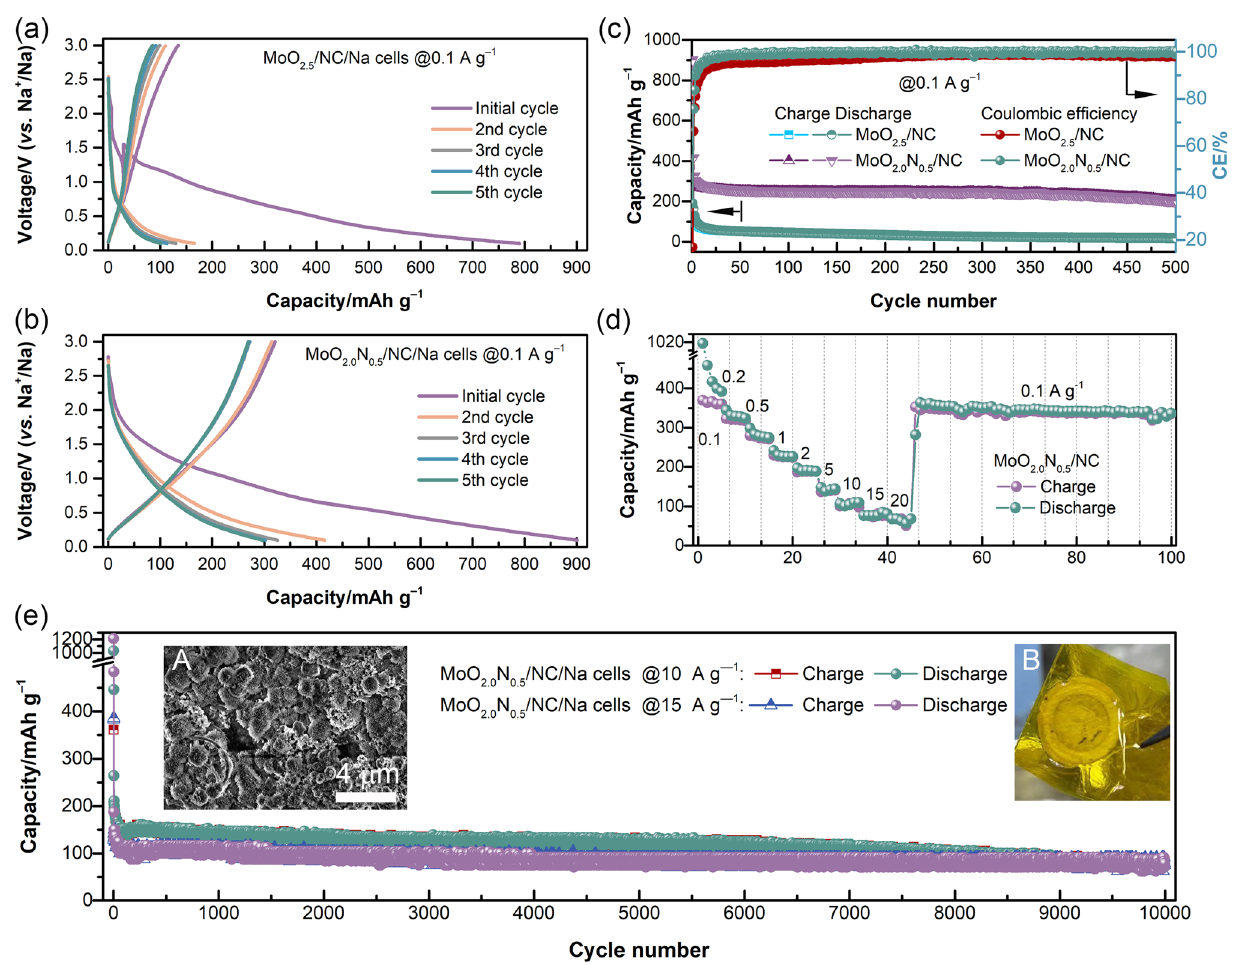
Fig. 5 Electrochemical performance of MoO 2.0 N 0.5 /NC electrode. Initial charge and discharge cycles of a MoO 2.5 /NC and b MoO 2.0 N 0.5 /NC. c Cycling performance of MoO 2.5 /NC and MoO 2.0 N 0.5 /NC. d Rate cycling performance of MoO 2.0 N 0.5 /NC. e Long-term cycling performance at current densities of 10 and 15 A g −1 . The insert figures of e shown A the SEM image of MoO 2.0 N 0.5 /NC electrode after 10,000 cycles at 10 A g −1 and B the digital picture of separator faced MoO 2.0 N 0.5 /NC electrode side. The MoO 2.0 N 0.5 /NC cell was disassembled after 10,000 cycles at 10 A g.